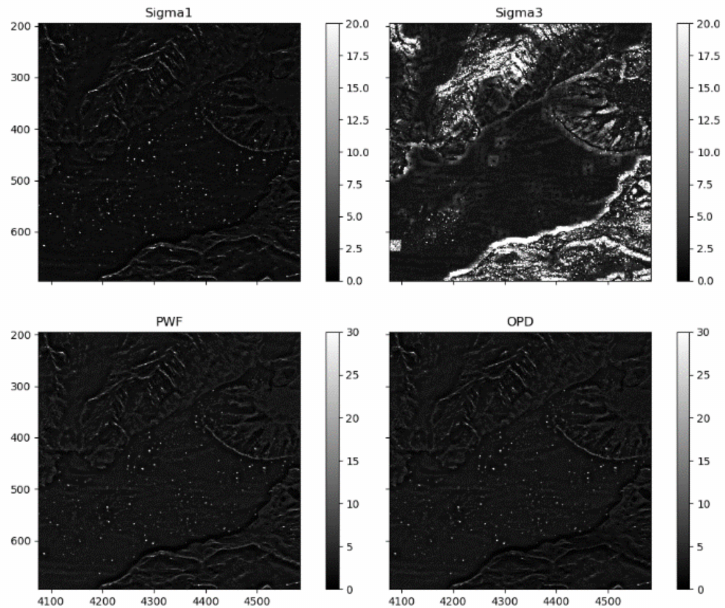
Figure 10. Iceberg detection σ 1 , σ 3 , the PWF, and the OPD for Blosseville. Image size is 400 × 600 pixels. Colourmaps indicate detection intensity.